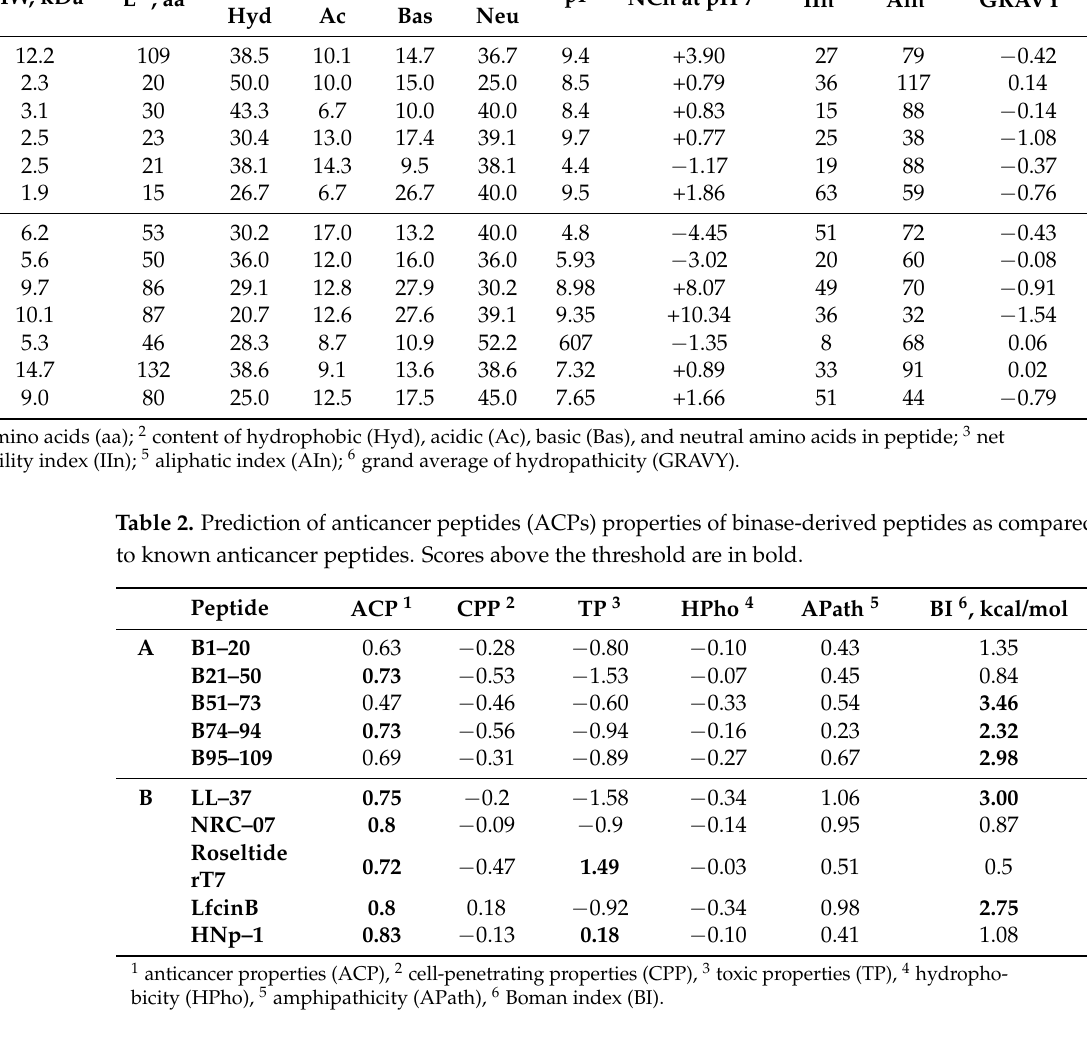
Table 1. The physical and chemical parameters of the binase-derived peptides (A) and epidermal growth factor receptor (EGFR) ligands (B) calculated from their amino acid sequences.